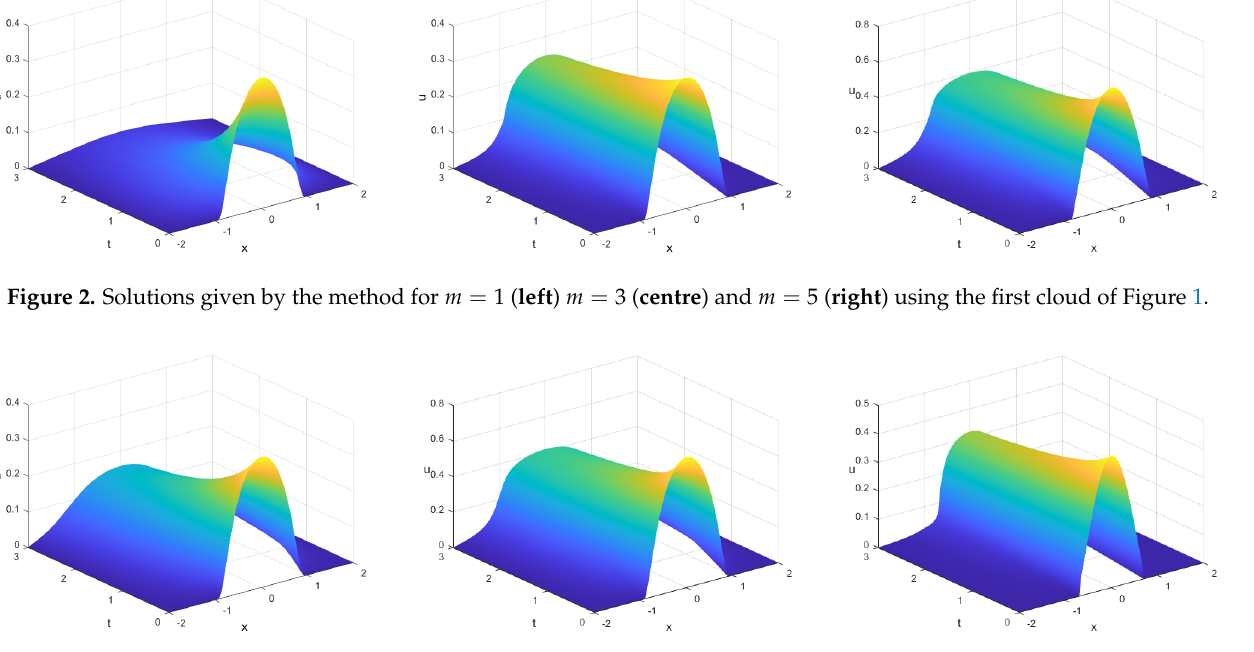
Figure 3. Solutions given by the method for m = 2 ( left ) m = 4 ( centre ) and m = 10 ( right ) using the second cloud of Figure